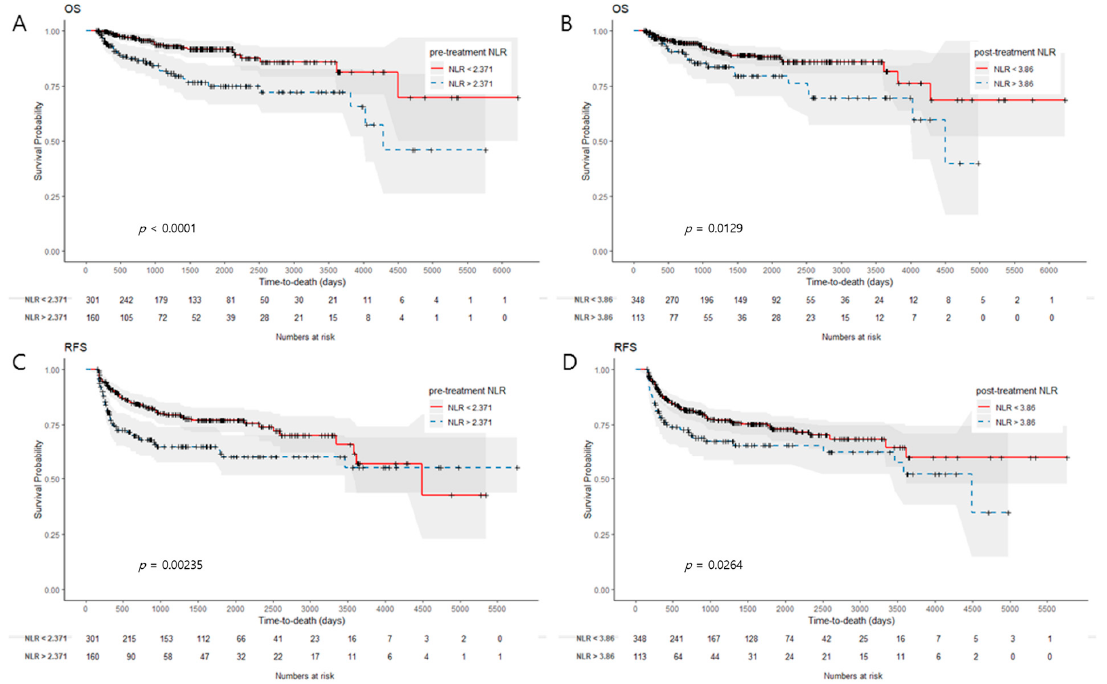
Figure 3. Kaplan–Meier survival curves for OS and RFS according to the different levels of NLR. ( A , B ) High pre-treatment and high post-treatment NLR was related to significantly worse OS ( p < 0.001 and p = 0.013, respectively); ( C , D ) High pre-treatment NLR and high post-treatment NLR also predicted worse RFS ( p = 0.002 and p = 0.026, respectively).